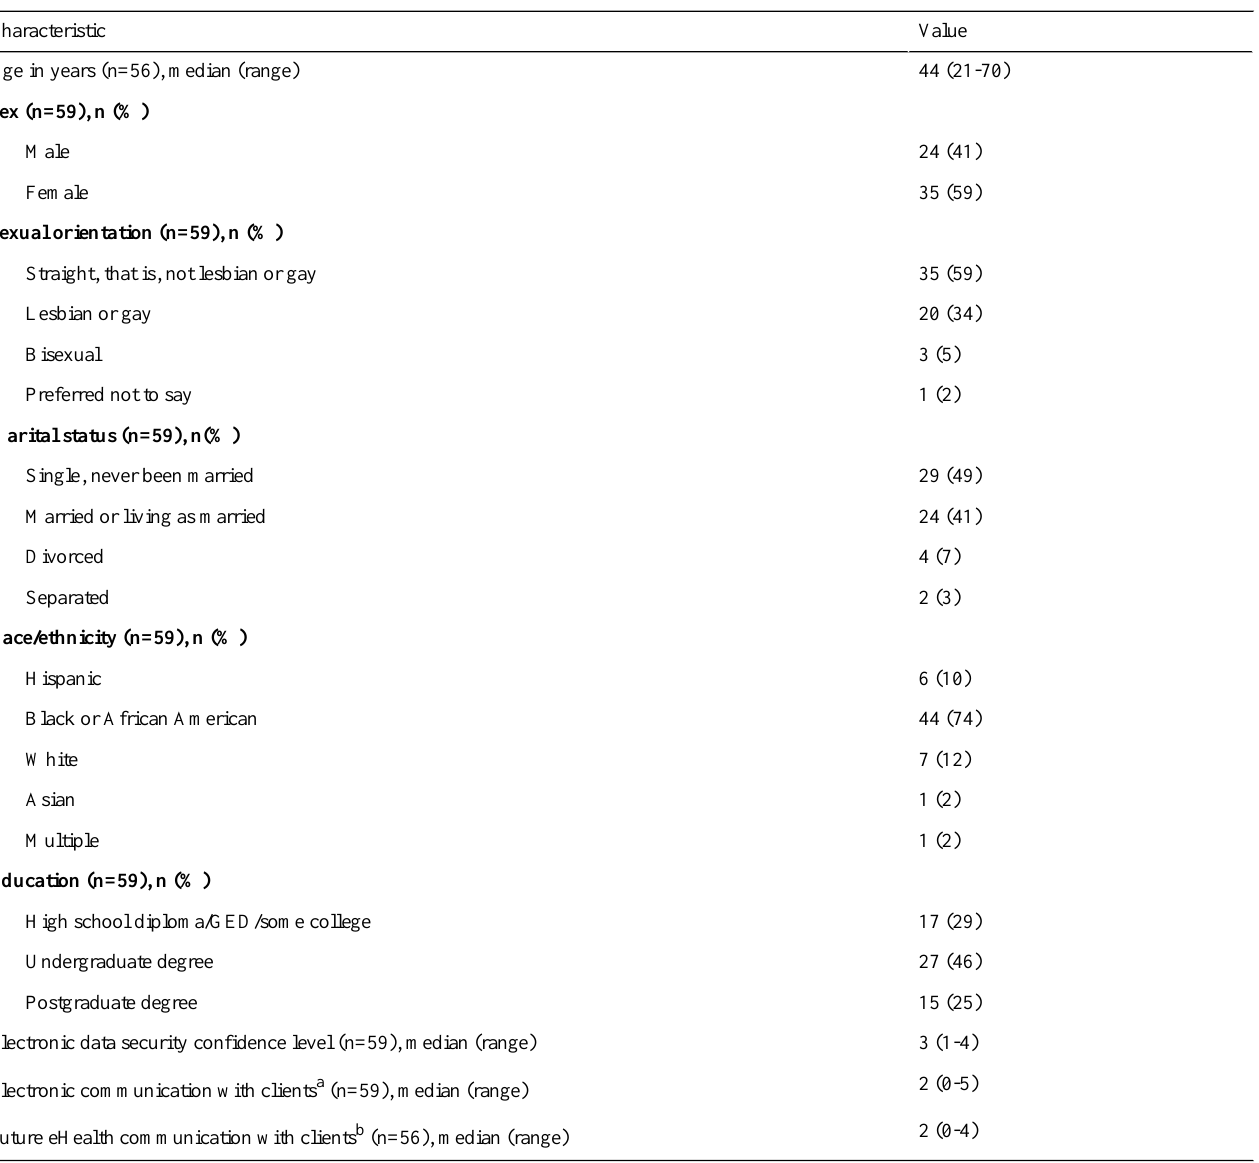
Table 1. Sociodemographic and eHealth communication characteristics of staff at community-based HIV/AIDS service organizations located in the southern United States